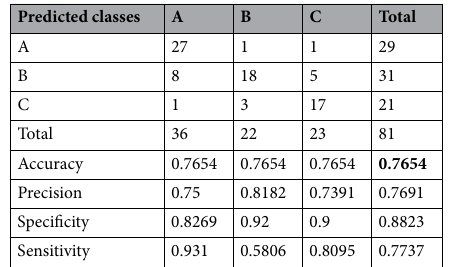
Table 2. The Confusion Matrix and Evaluation Metrics of CNN Classification. Significant values are in